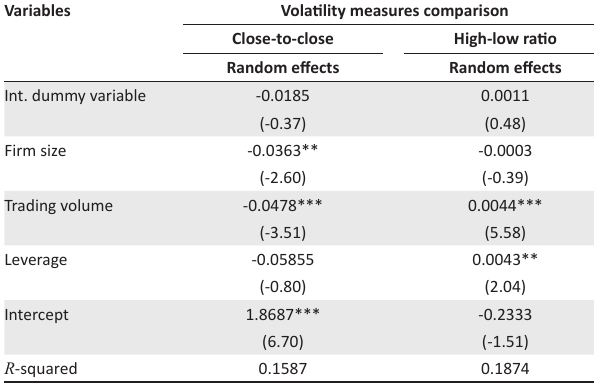
TABLE 5b: Domestic versus internationalised stocks – Matched sample.